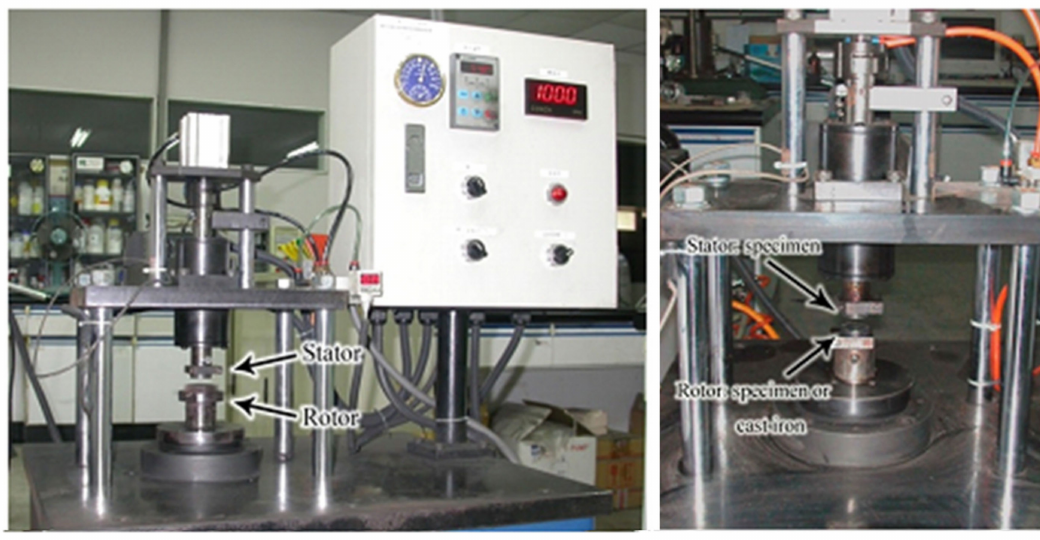
Figure 1. The friction and wear